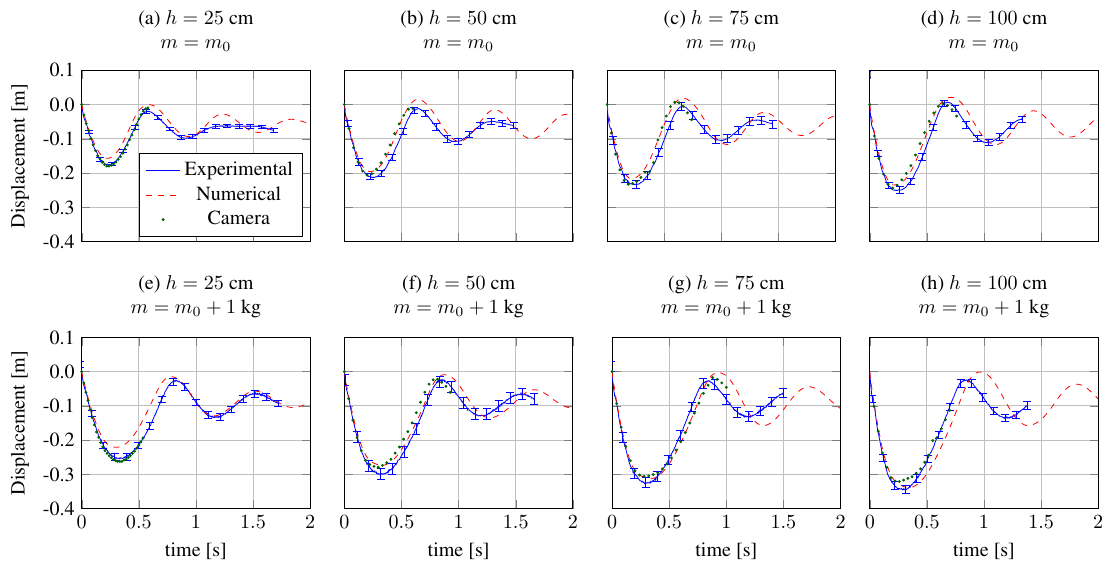
Figure 8. Displacement of the specimen center of mass. Comparison between CFD and experiments for different h and m : ( a ) h = 0.25 m and m = m 0 ; ( b ) h = 0.5 m and m = m 0 ; ( c ) h = 0.75 m and m = m 0 ; ( d ) h = 1.00 m and m = m 0 ; ( e ) h = 0.25 m and m = m 0 + 1 kg; ( f ) h = 0.5 m and m = m 0 + 1 kg; ( g ) h = 0.75 m and m = m 0 + 1 kg; ( h ) h = 1.00 m and m = m 0 + 1